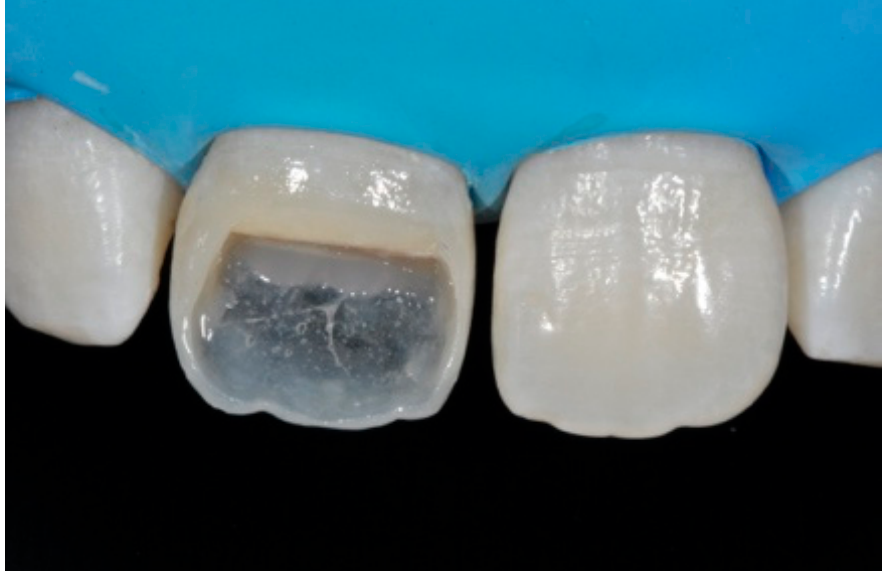
Figure 9. After frame modification silane coupling agent and adhesive procedures are applied. Reprinted from Restauri diretti nei settori anteriori, G. Paolone, S. Scolavino, © 2021, with permission from Quintessence Publishing Italy.